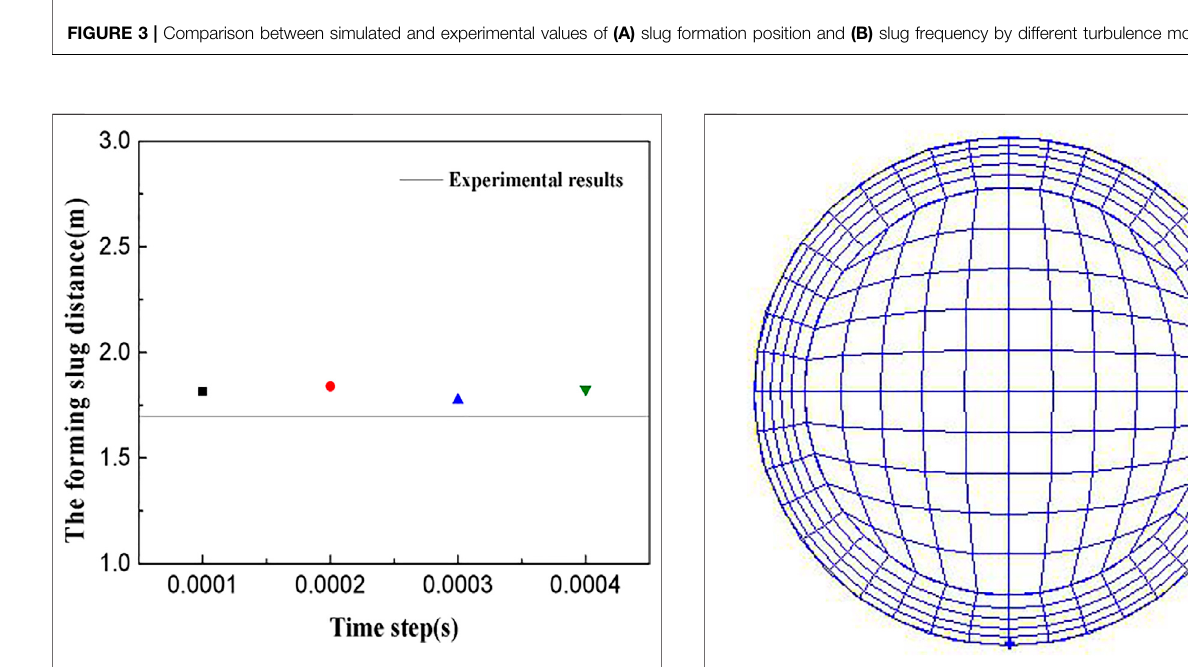
FIGURE 4 | Variation of slug formation position with time step.